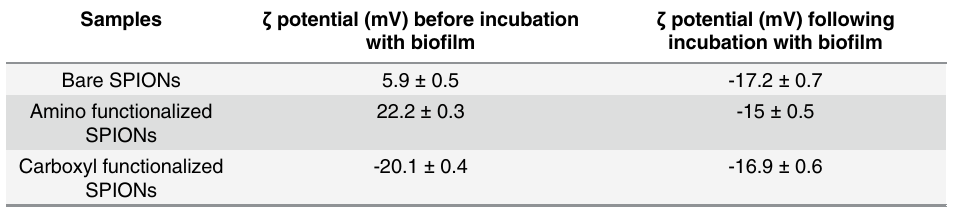
Table 1. Zeta potential values of the SPIONs determined before and after incubation with the biofilm.